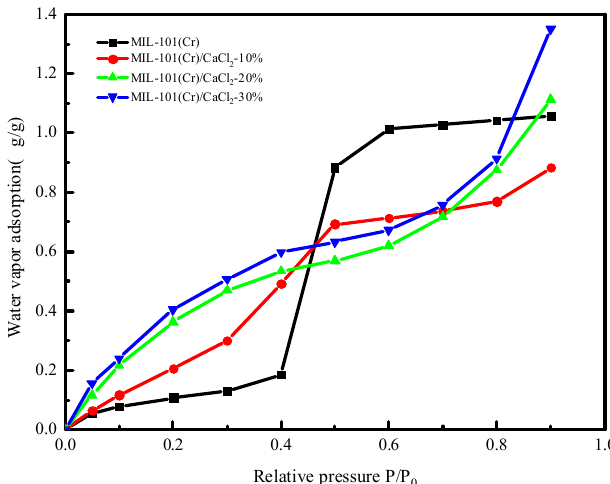
Figure 5. Water sorption isotherms of MIL-101(Cr) andMIL-101(Cr)/CaCl 2 composites at 298 K.